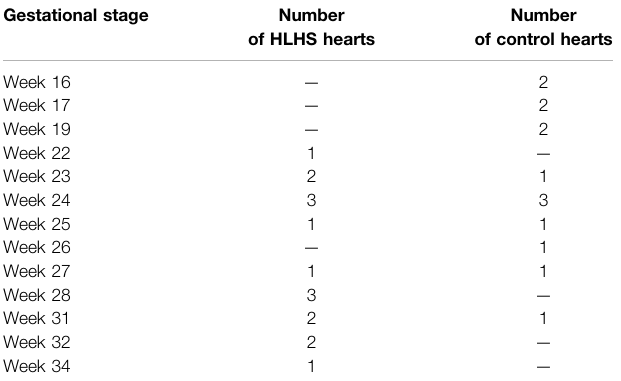
TABLE 1 | The number of sample fetal hearts used for analysis of chamber cross- sectional areas at different gestational stages. Gestational